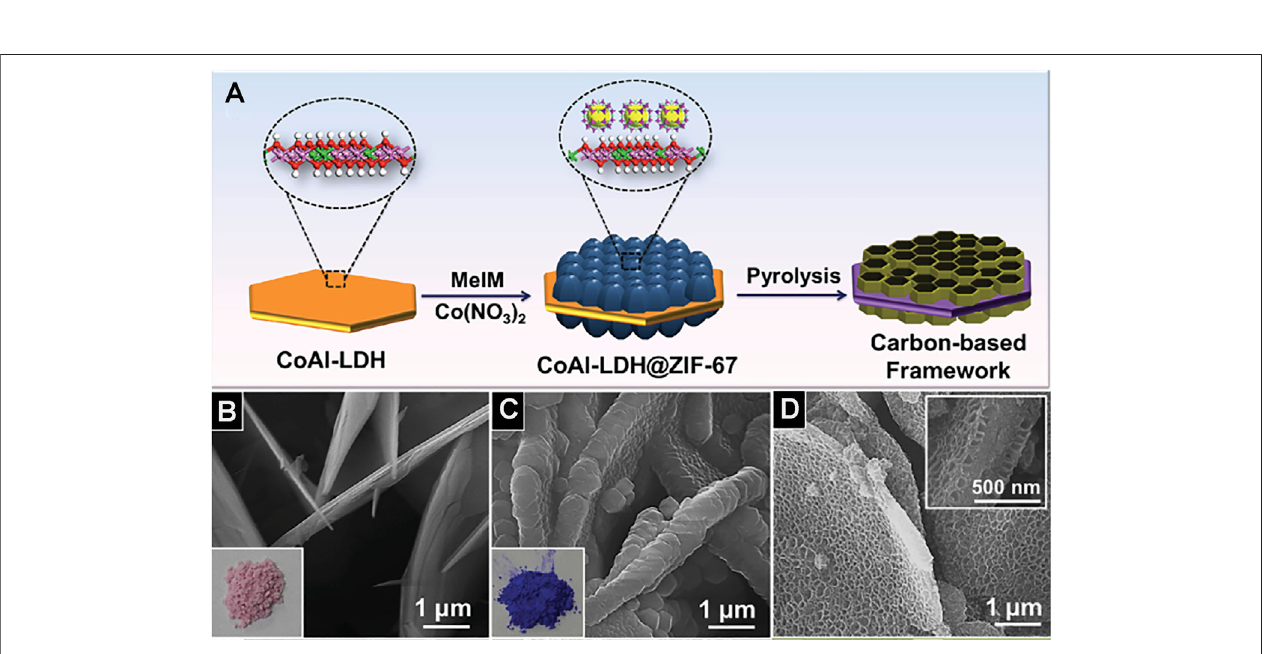
FIGURE 9 | (A) Schematic illustration for the synthesis of porous carbon-based framework. SEM images of CoAl-LDH (B) , CoAl-LDH@ZIF-67 (C), and LDH@ZIF- 67-800 (D) (Li et al., 2016).